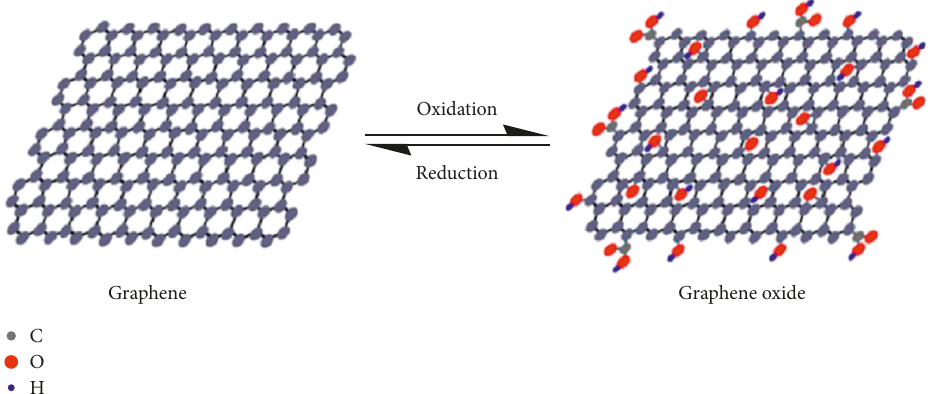
Figure 4: Structural model of graphene and graphene oxide (taken from